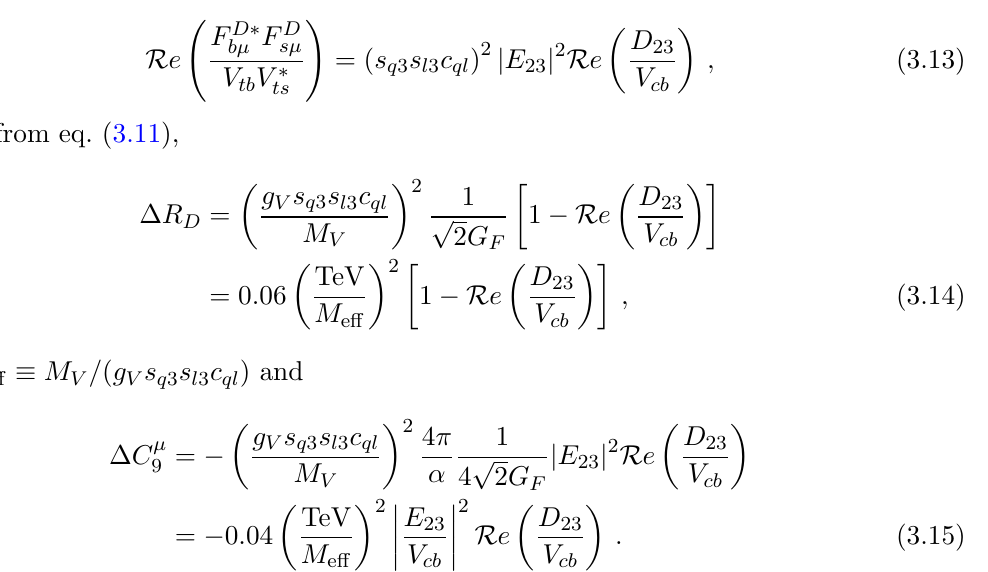
= 2 , 3 , 4 , 5 , 6 % and ∆ C µ = /x 2 D e 9 { } − = E 23 /V cb e | |